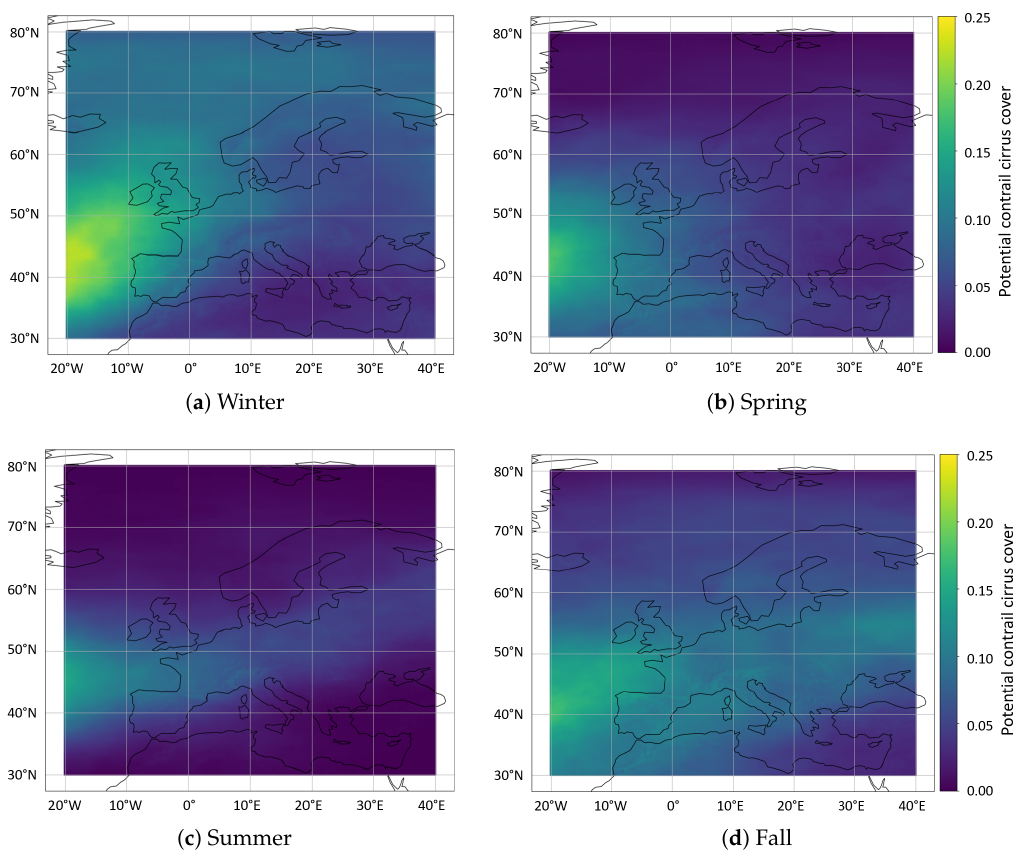
Figure A3. Seasonality in contrail formation and persistence, plotted over Europe at 200 hPa using a threshold for the relative humidity of